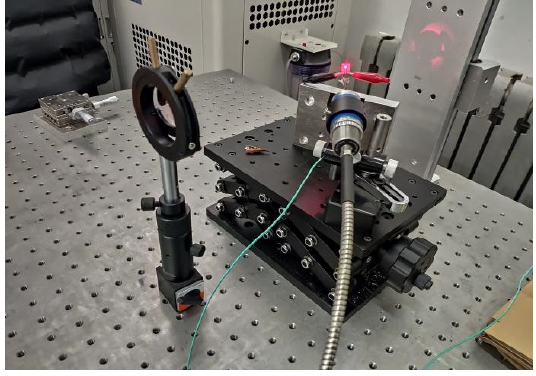
Figure 14. Thin-film thermocouple dynamic test experiment site. Table 4. Time constants of thin-film thermocouple at different laser